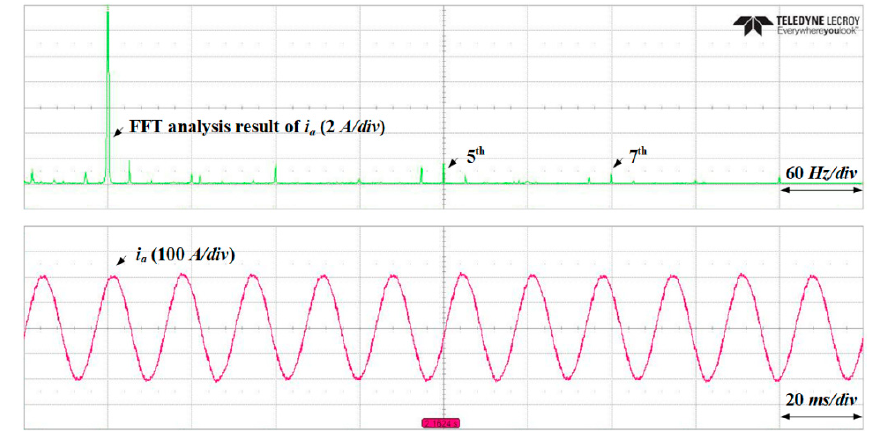
Figure 23. Experimental results when a harmonic compensation method is applied: THE method.